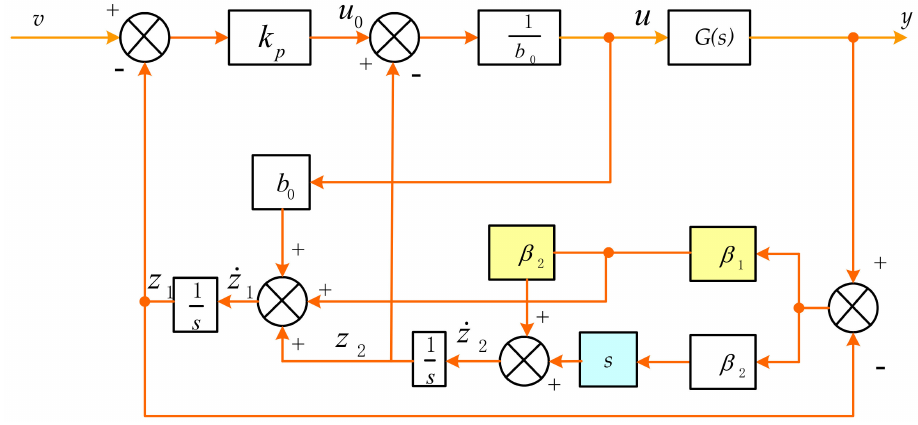
Figure 7. Block diagram of improved LADRC control